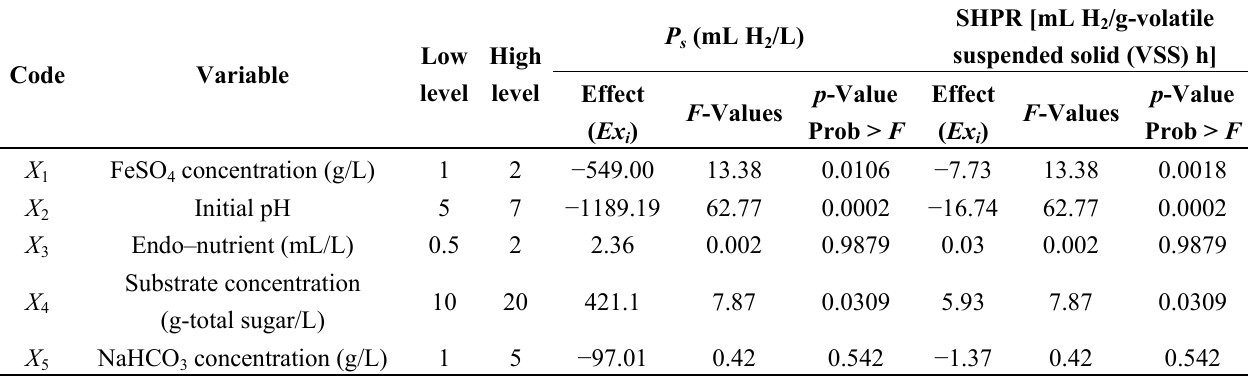
Table 1. Levels of the variables and statistical analysis in Plackett–Burman design for P and